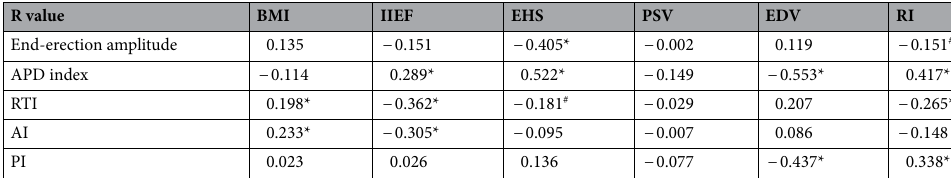
Table 3. The correlation among PPG signals and clinically observed parameters. EDV End-diastolic velocity in “end-erection” status. * p < 0.05; # p = 0.09.